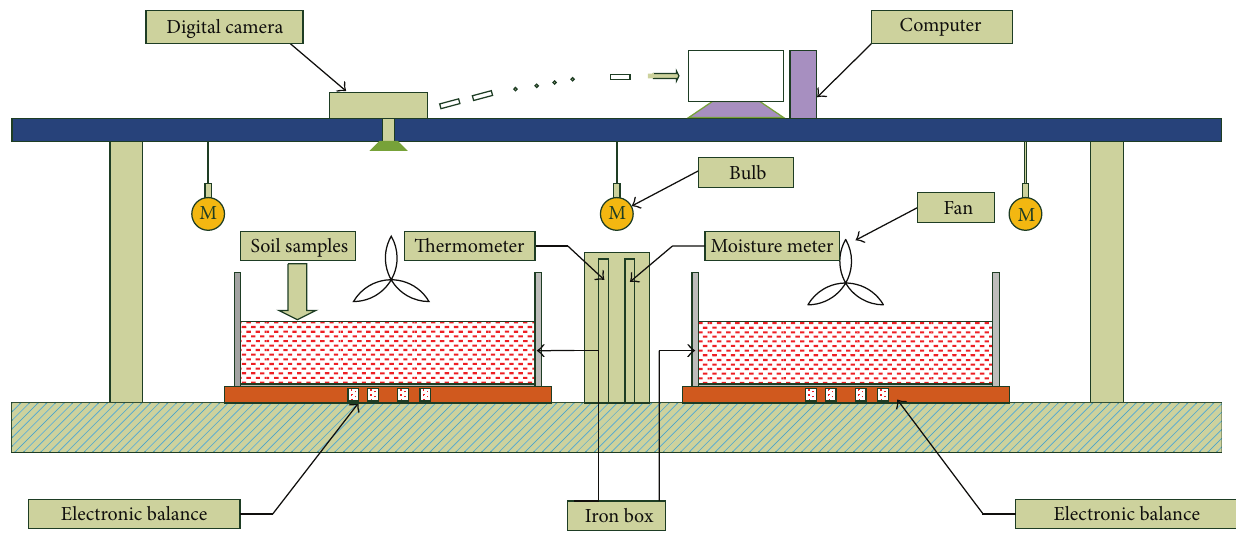
Figure 1: Sketch of the experiment equipment for cracking test.